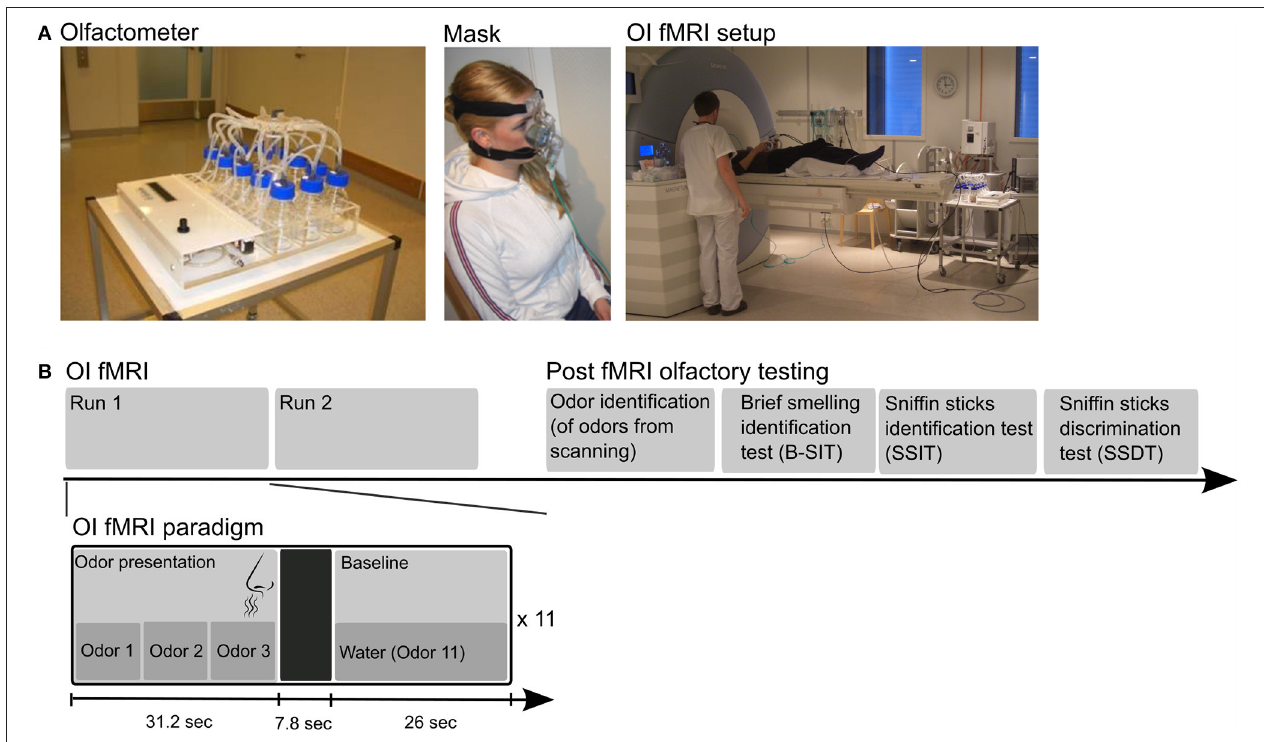
FIGURE 1 | The top row (A) displays photos of the automated olfactometer to the left, followed by a person wearing the olfactory mask in the middle, and the setup in the scanner room on the right. (B) The lower row shows the design of the fMRI experiment. The experiment consisted of two fMRI runs with odor identification (OI) followed by psychophysical olfactory tests completed after MRI scanning. The fMRI paradigm was a mixed block (OI state)–event (successful OI) design (bottom row). Each run consisted of 11 olfactory blocks, and each olfactory block consisted of three odors in a random order, followed by a 7.8-s null event period (to ensure removal of scented air) and a non-odor baseline condition (water). The persons in the photos have provided consent for